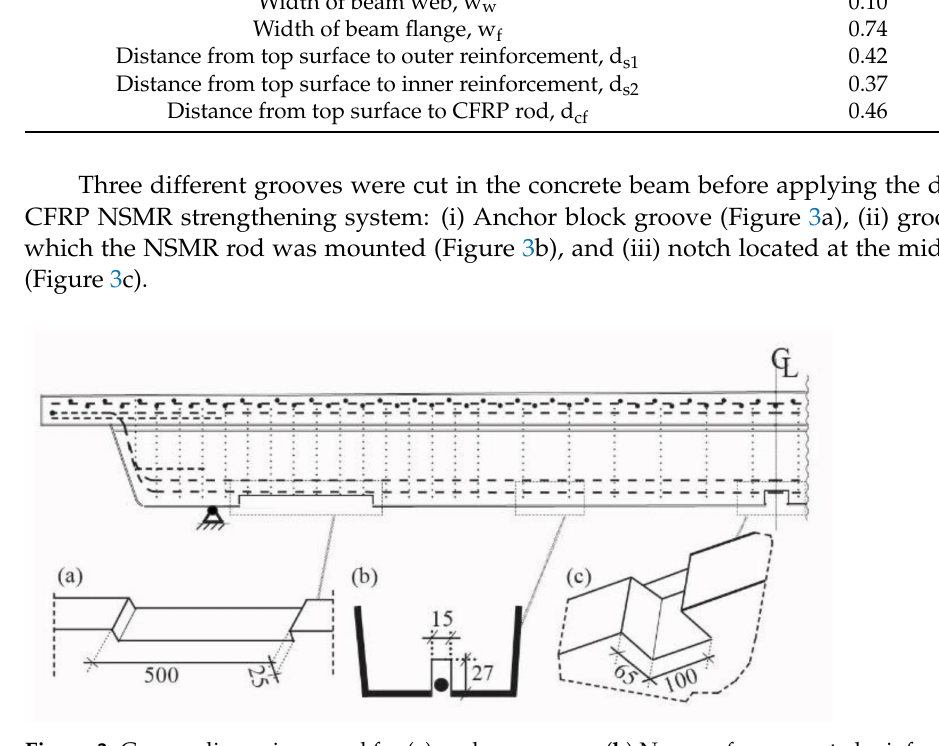
Figure 3. Groove dimensions used for ( a ) anchorage zone, ( b ) Near surface mounted reinforcement (NSMR), and ( c ) mid-span notch. Note: units in